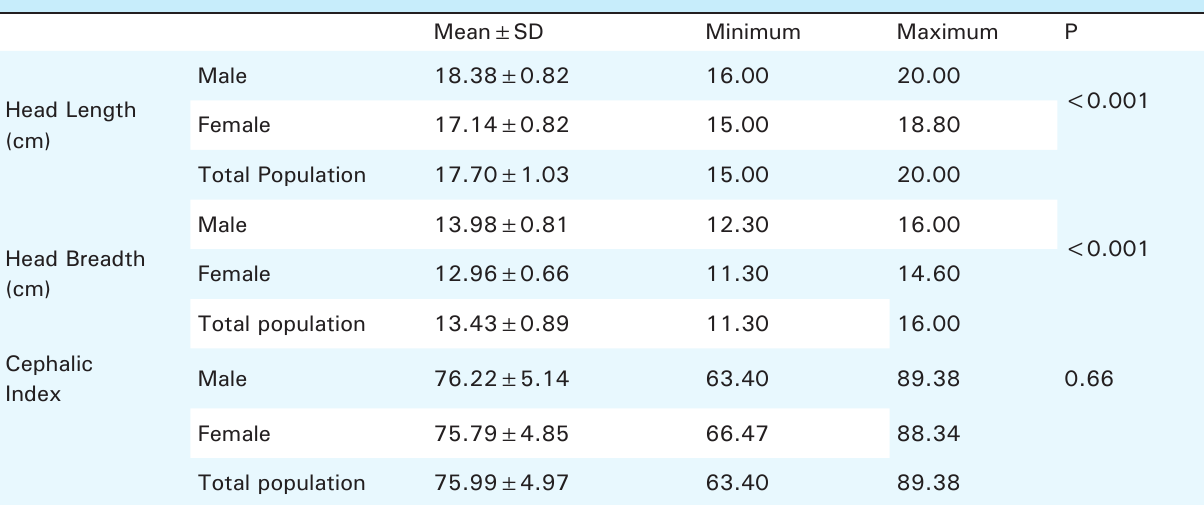
Table 1. Statistics showing head length, breadth and cephalic index.